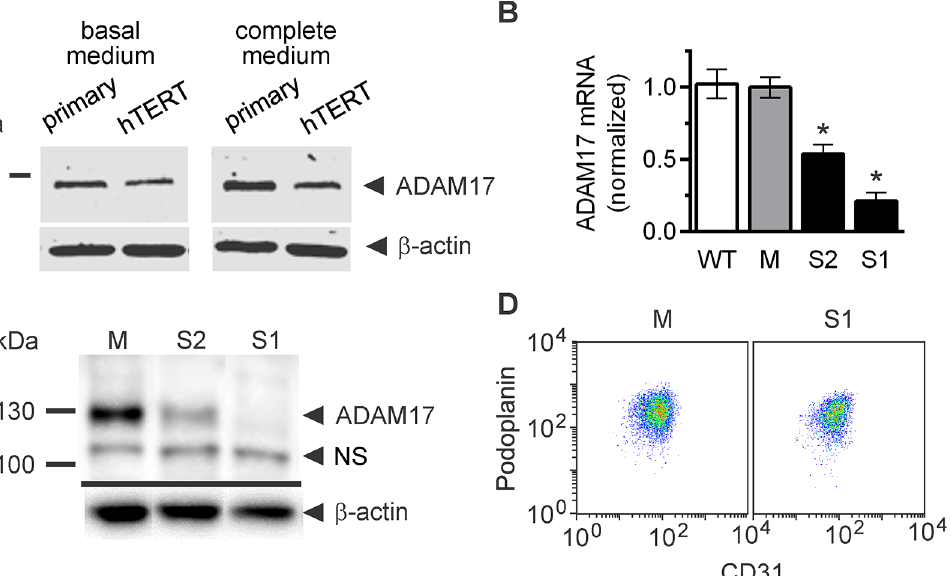
Fig 1. Analysis of ADAM17 silencing in lymphatic endothelial cells (LEC). ( A ) Western blotting analysis comparing the levels of ADAM17 in primary LEC vs. hTERT-immortalized LEC. ( B ) Quantitative RT-PCR analysis of ADAM17 mRNA levels in the wild type LEC (WT), LEC stably transduced with lentiviral vector encoding mock (control) shRNA (M), and LEC stably transduced with lentiviral vectors encoding shRNA sequences targeting ADAM17 – no. 2 alone (S1) or nos. 3 and 5 (S2). Bars represent mean ± SD of three independent experiments performed in duplicates. * P < 0.01 vs M. ( C ) Western blotting analysis of ADAM17 protein levels in lysates from the LEC sublines. NS – nonspecific band ( D ) Flow cytometry analysis of the LEC markers, CD31 and podoplanin, in M and S1. ( A, B, C ) Shown are representative results of two ( A ) or three ( B, C ) independent analyses